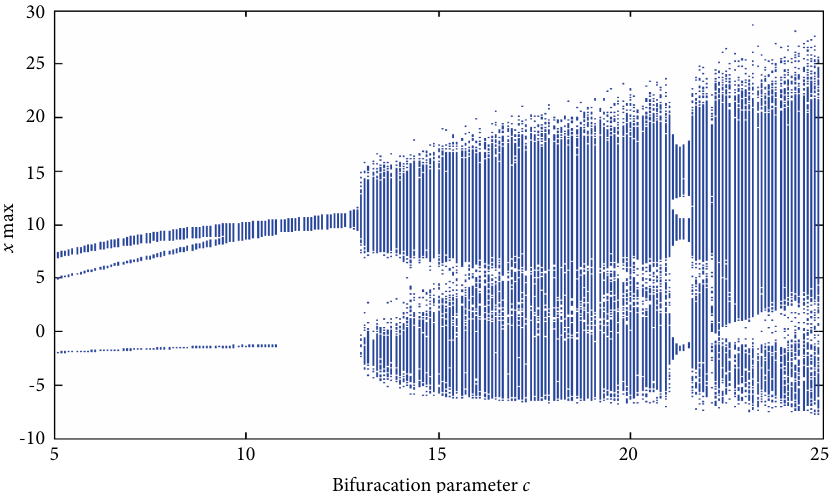
Figure 2: Bifurcation diagram of modified